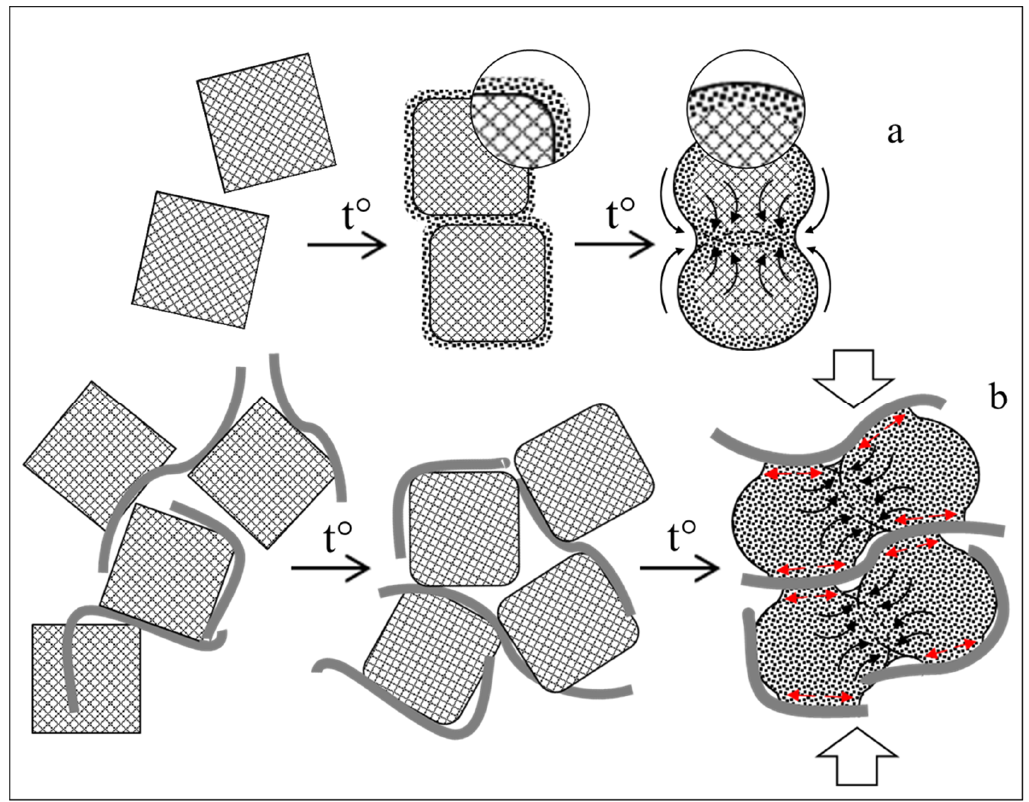
Figure 12. Schemes of the possible sintering mechanisms of the single nano-zirconia ( a ) and the graphene-zirconia composite ( b ).